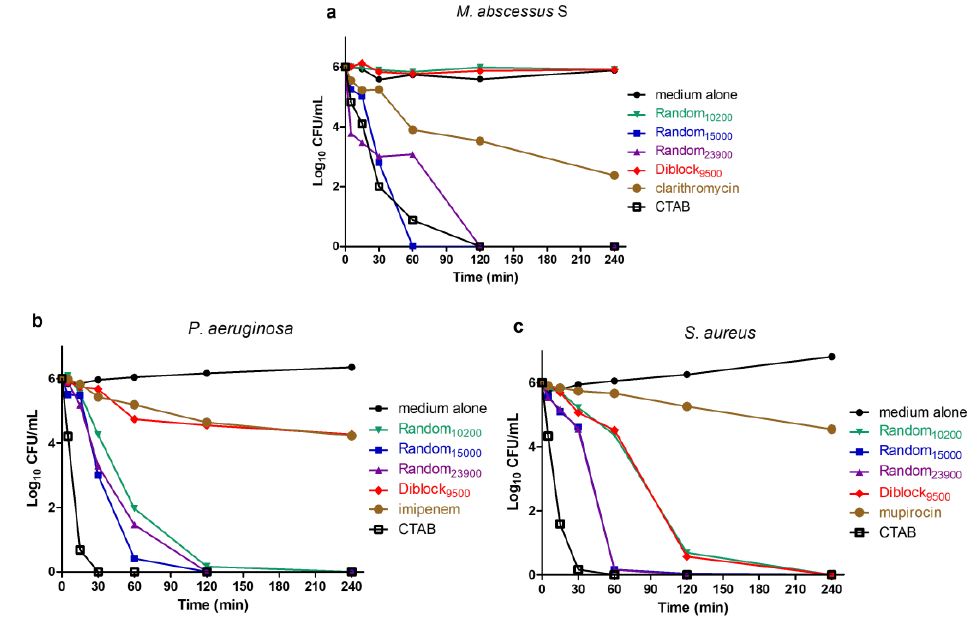
Figure 4. Time-dependent killing activity of the copolymers. Bacterial strains ( M. abscessus S ( a ), P. aeruginosa ( b ) and S. aureus ( c ), at approximatively 10 6 CFU/mL initial bacterial density) were incubated with Random or Diblock copolymers at 4 × MIC concentrations. Results are expressed as the mean of logarithm of the number of CFU/mL as a function of time (n = 3). To facilitate visualiza- tion, SD are not represented. Conventional bactericidal antibiotics (i.e., clarithromycin, imipenem, and mupirocin for M. abscessus S, P. aeruginosa , and S. aureus , respectively) in addition to CTAB (a quaternary ammonium inducing bacterial killing by membranolytic effect) were used as